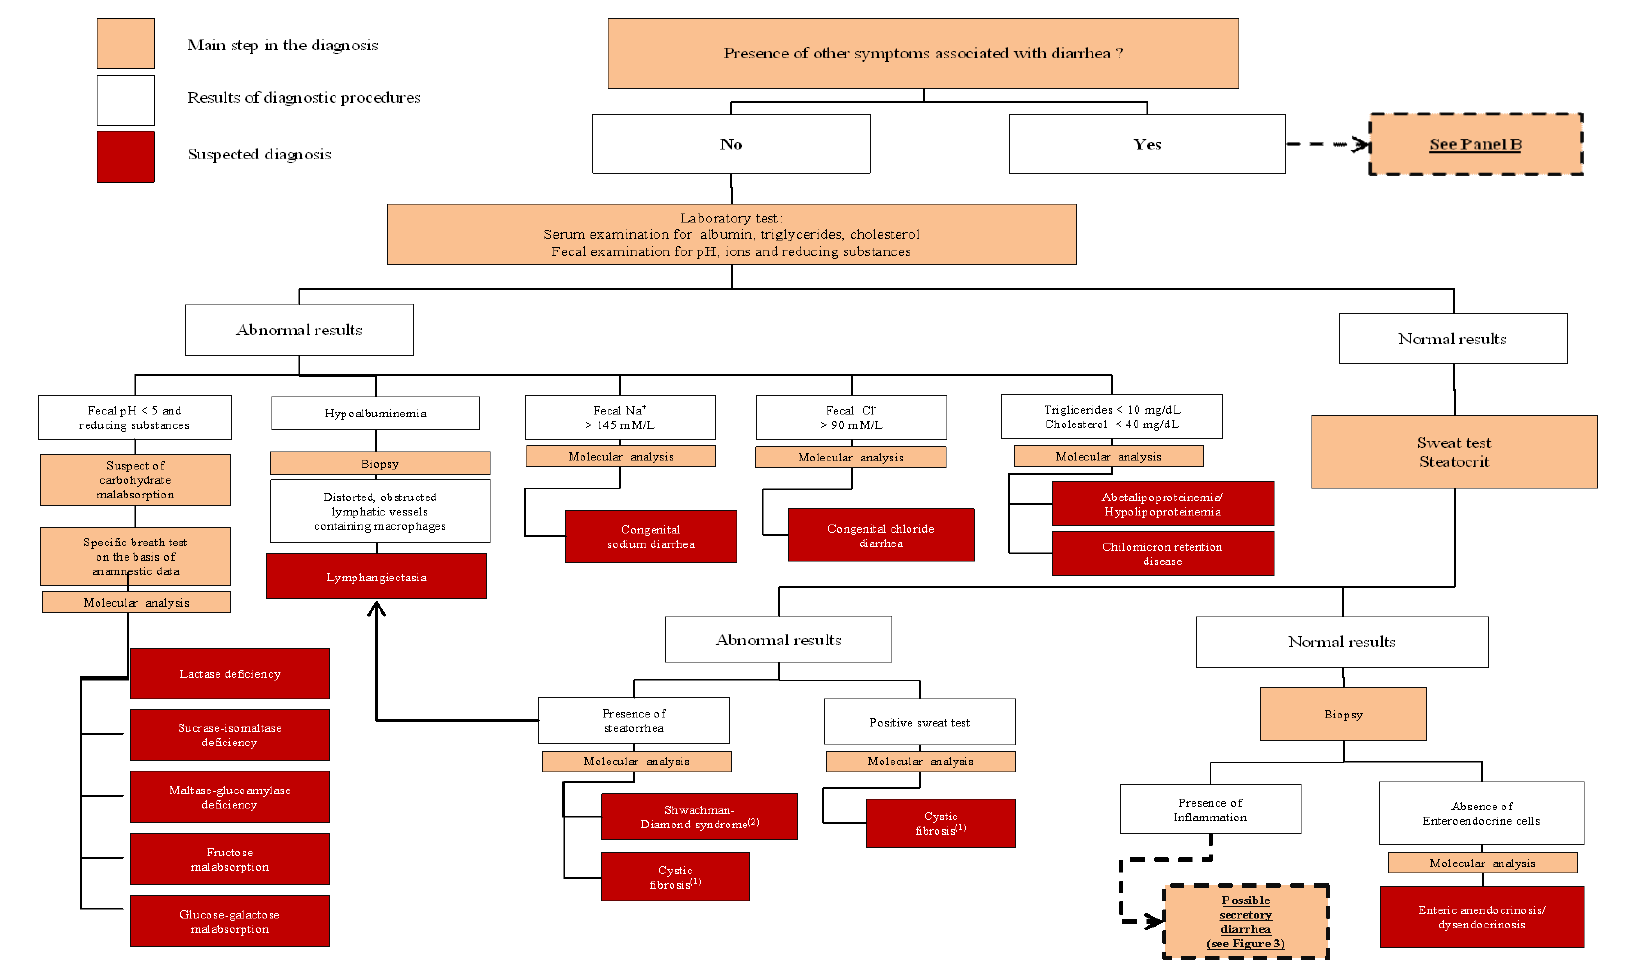
Figure 2. Panel A. Diagnostic diagram of congenital diarrheal disorders determined by an osmotic mechanism. Panel B. Diagnostic diagram of congenital diarrheal disorders determined by an osmotic